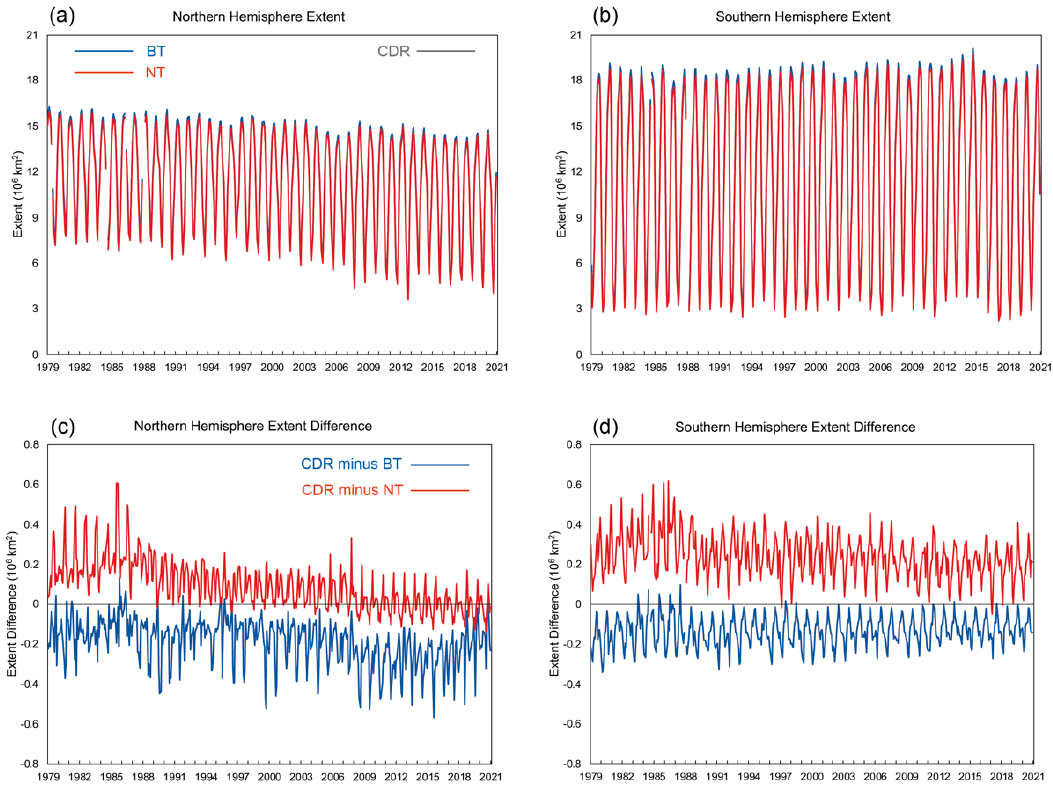
Figure 3. Total monthly sea ice extent, 1979–2020, for ( a ) Northern Hemisphere and ( b ) Southern Hemisphere, and CDR–BT and CDR–NT extent difference for ( c ) Northern Hemisphere and ( d ) Southern Hemisphere. ( d ) Southern